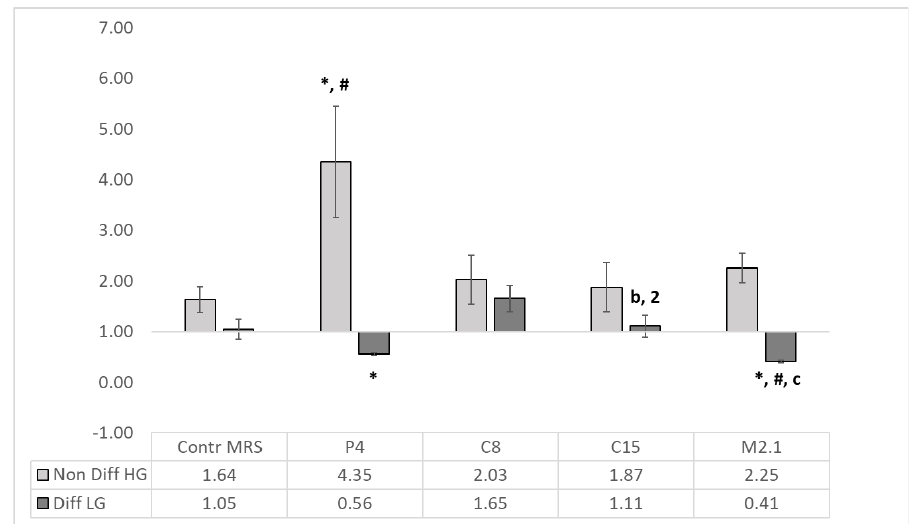
Figure 4. Pro-/anti-apoptotic Bax/Bcl-2 ratio. The absolute qPCR quantities of BAX and Bcl-2 gene expression are presented as Bax/Bcl-2 ratio ( n = 4, ± SEM). The established significant differences are expressed as follows: * significance to the MRS HG/LG Control; # significance between groups; the significance in differentiated (LG) group is defined as follows: with small letters between P4 and C8 (a), C15 (b) and M2.1 (c); with numbers between M2.1 and C8 (1) and C15 (2).